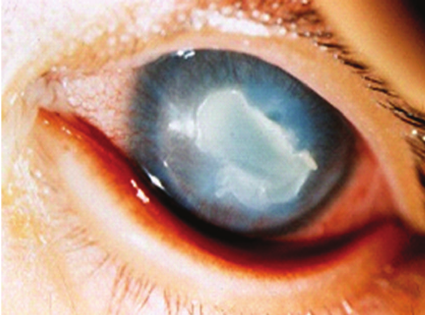
Figure 12: Fungal keratitis post-PRK hypopyon and central ulcer with satellite lesions.